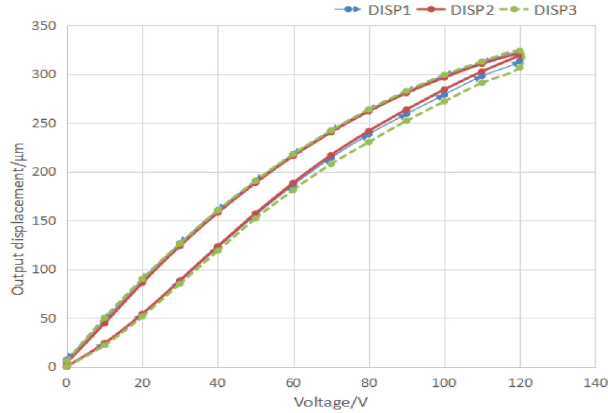
Fig. 12. Voltage and displacement diagram of the micro- displacement ampli fi cation mechanism. Table 5. Voltage and displacement comparison of PZT before and after ampli fi cation.